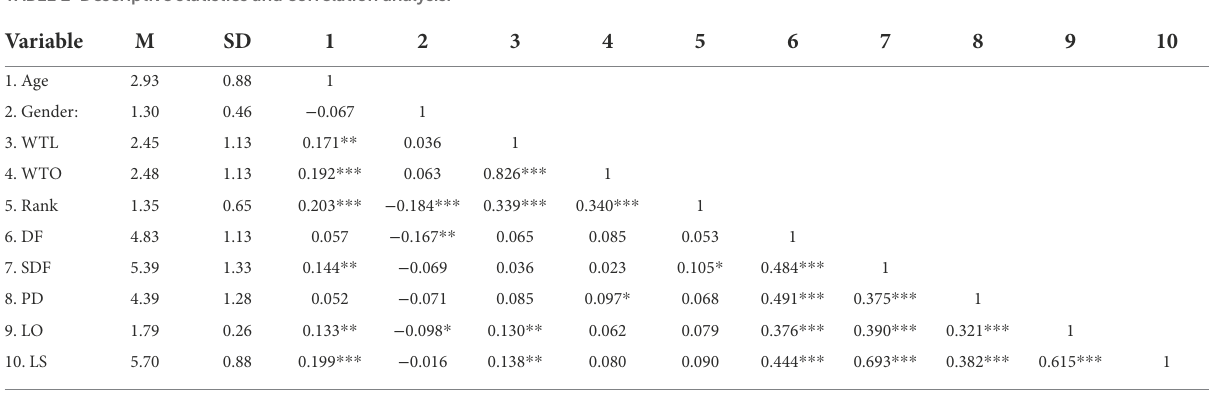
TABLE 2 Descriptive statistics and correlation